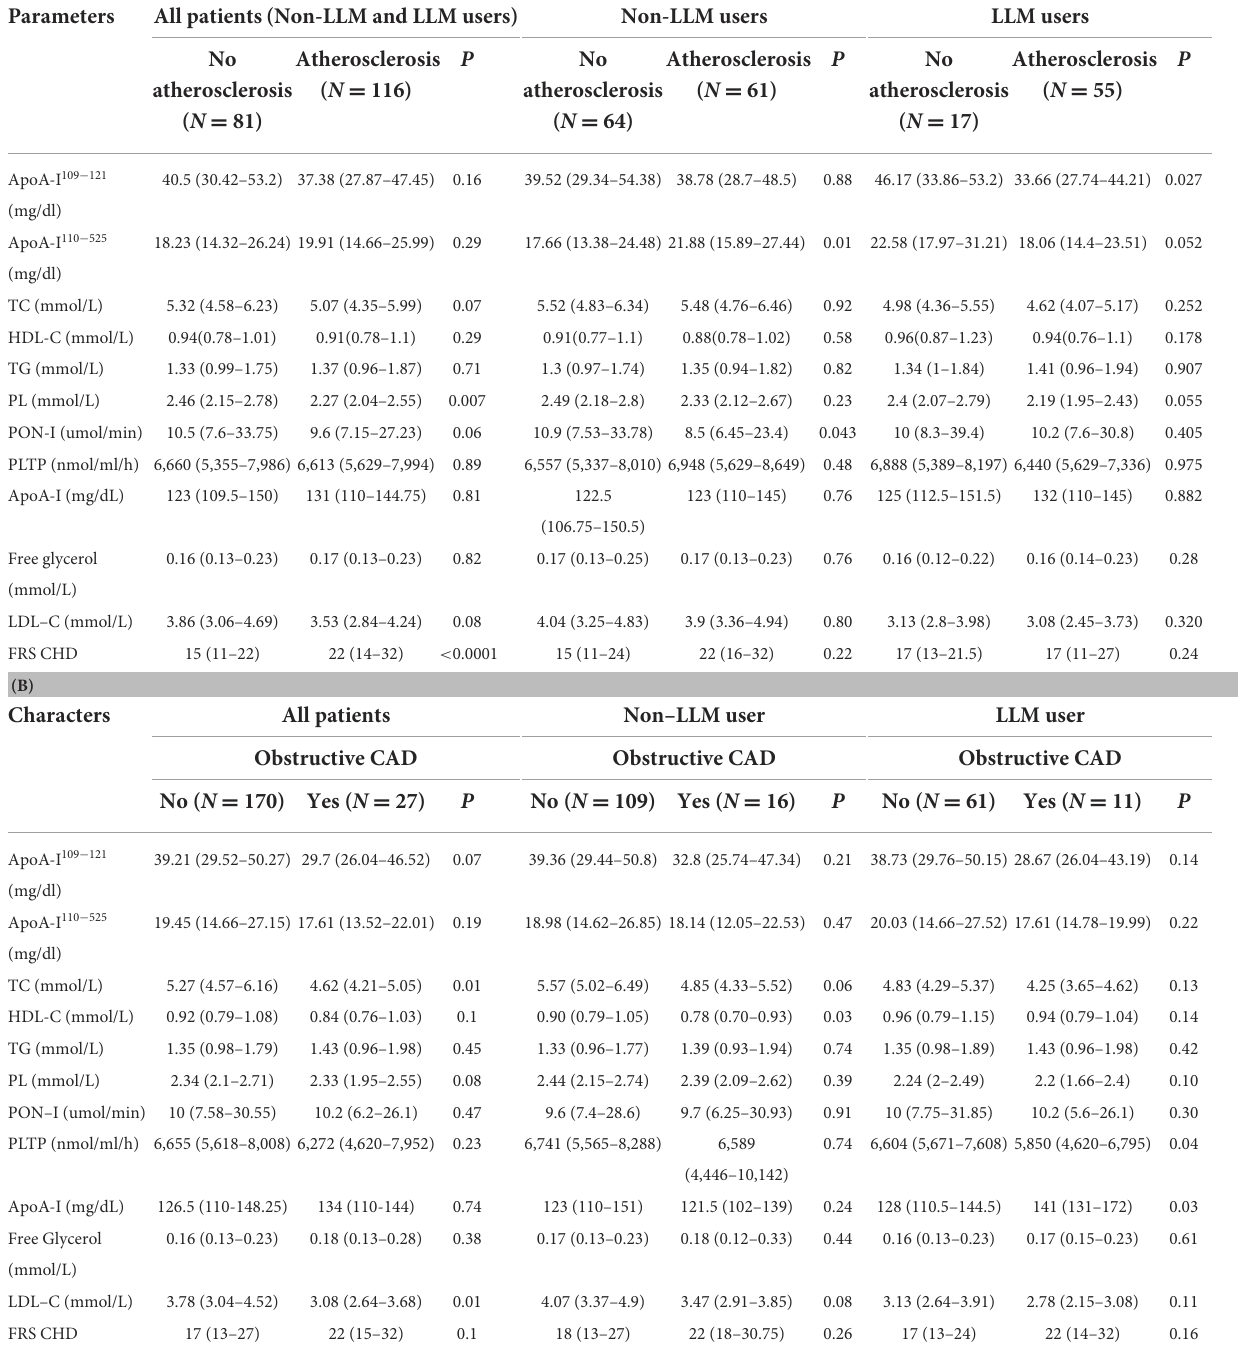
TABLE 2 Comparison of the direct two-site apoA-I assays (assay 109–121 and assay 110–525), biochemical parameters, and FRS CHD between patients with and without atherosclerosis (A), and with and without obstructive CAD